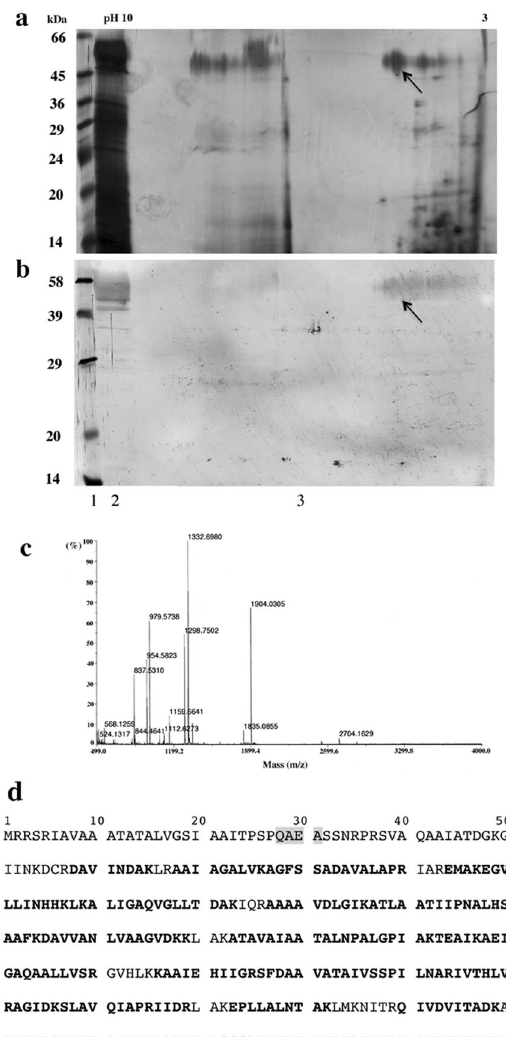
Figure 2. Characterization of the 58 kDa P. acnes surface protein. Concentrated proteins (200 μ g) were separated by 2D-electrophoresis. ( a ) Proteins were detected by silver staining. ( b ) Fibrinogen binding activity was assessed with biotinylated human fibrinogen (0.1 μ g/ml). Lane 1: molecular weight standard. Lane 2: sample separated by 10% SDS-PAGE (1DE) only (50 μ g of protein). Lane 3: sample after 2DE. The arrow indicates the spot excised for identification by MALDI-ToF. ( c ) MALDI-ToF spectrum obtained for the spot of interest. ( d ) Peptide sequence of the 58 kDa protein with 64% coverage (in bold). The sequence signal is highlighted in gray, the repeated PT domain is underlined, and the LPXTG motif is double-underlined. Based on its binding capacities (to hFg, this study; and to dermatan sulfate 31, 32 ), the 58 kDa protein was abbreviated